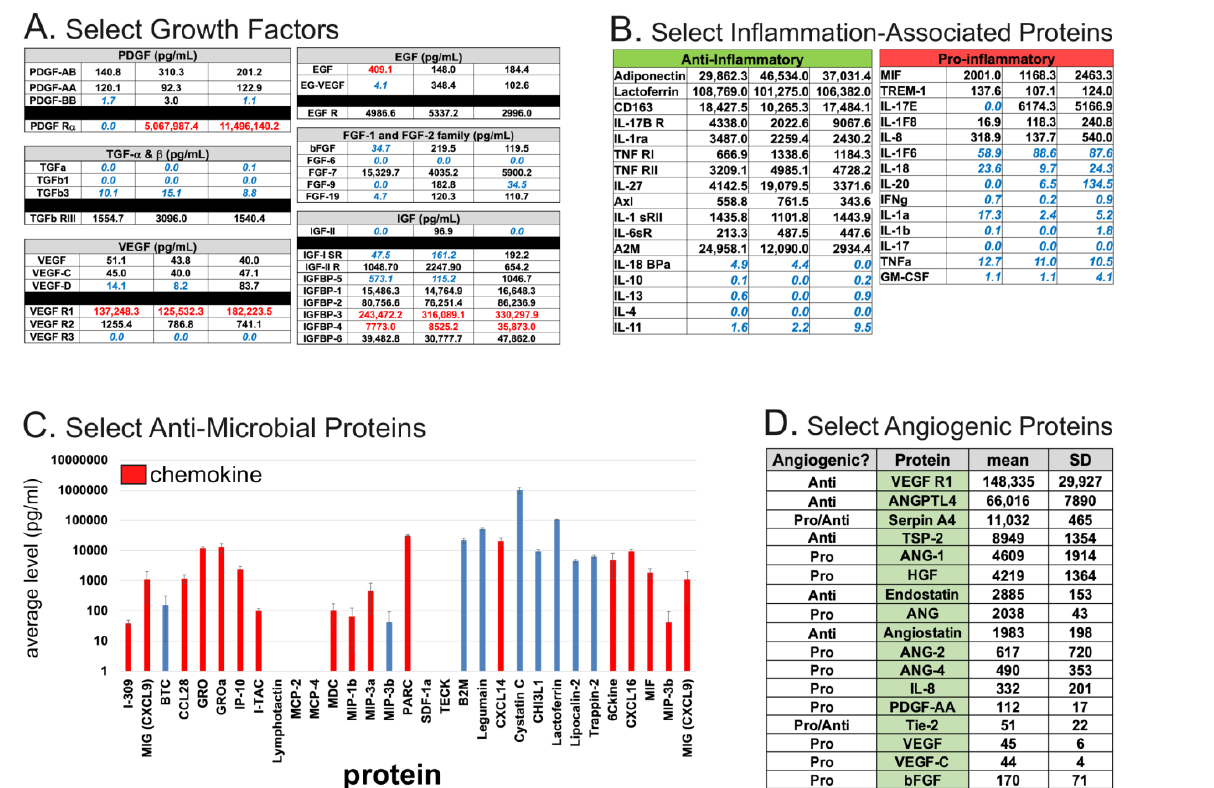
Figure 2. Summaries of select biomolecules of interest identified by multiplexed ELISA [15]. Each classification of the proteins shown was based on Gene Ontology annotations from the above-referenced study. ( A ). Select growth factors measured by ELISA from three independent donor-derived clinical grade cfAF samples. The growth factor is indicated by top header and left-most column, with the levels (pg/mL) measured indicated for each of three independent donors. Values in blue text indicated those below the level of detection for positive control, and those in red text indicate those above the level of detection for positive control. ( B ). Select inflammation-associated proteins measured as in part ( A ), and separated by anti-inflammatory (left) or pro-inflammatory (right) annotation. Values are shown in pg/mL and for each donor-specific batch of clinical grade cfAF as in ( A ). ( C ). Select mean values (pg/mL) of anti-microbial proteins shown by bar graph with error bars indicating standard deviation, as calculated in ( A , B ). Those shown in red are also annotated as chemokines. ( D ). Select angiogenic proteins shown, with “Angiogenic?” column header indicating whether the specific protein is annotated as pro- or anti-angiogenic, “Protein” column header indicating protein name, “mean” indicating mean value (pg/mL) from the three independent donor-derived lots of clinical grade cfAF as above, and “SD” indicating the standard deviation from the mean value.